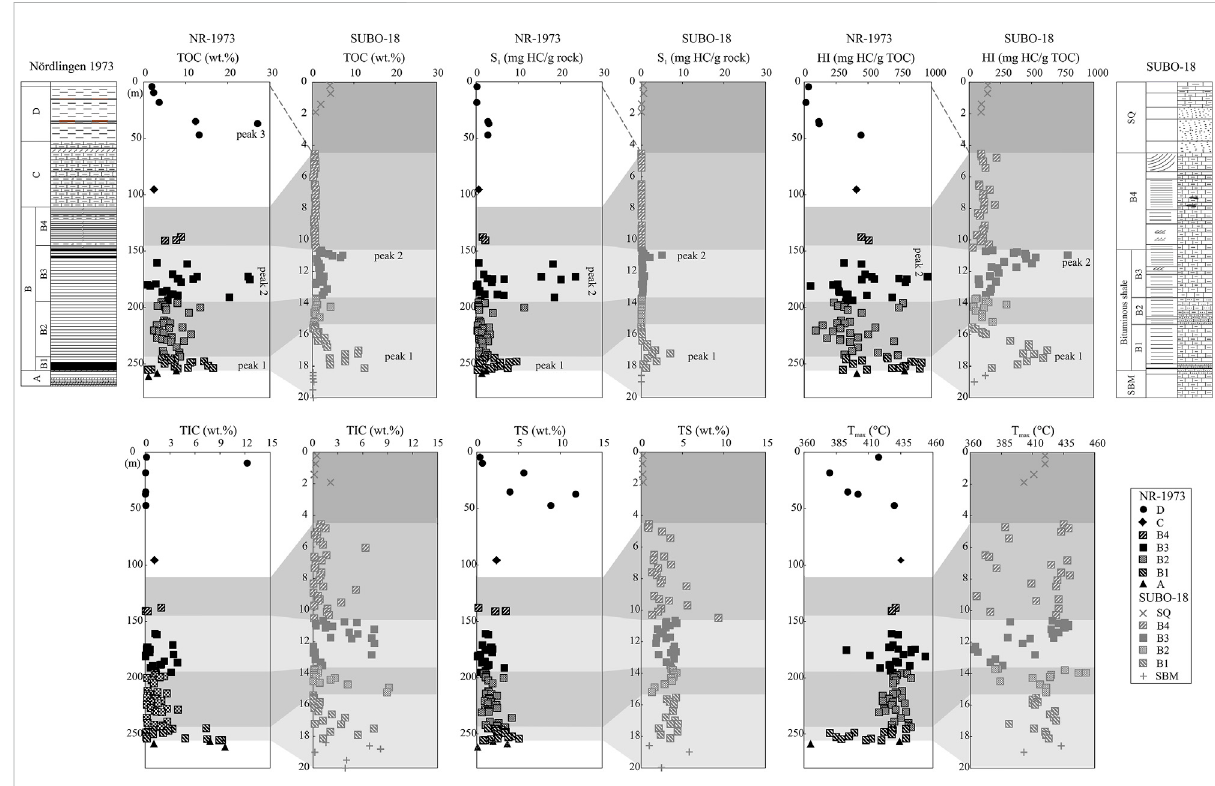
FIGURE 3 Bulk elemental data (TOC=total organic carbon content, TIC=total inorganic carbon content, TS=total sulfur content) and Rock-Eval indices